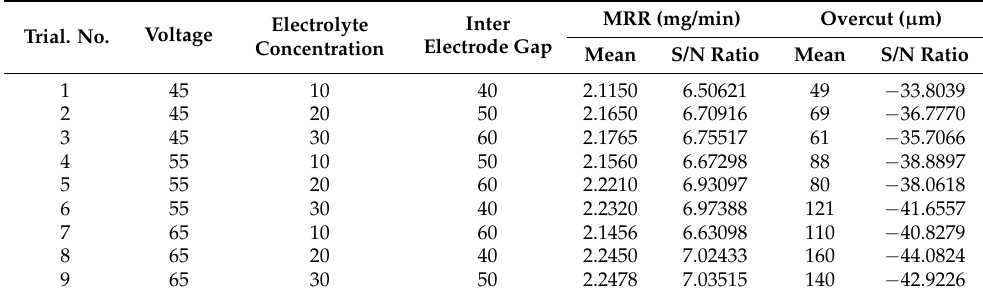
Table 2. Obtained Results for Taguchi’s Methodology. Trial.